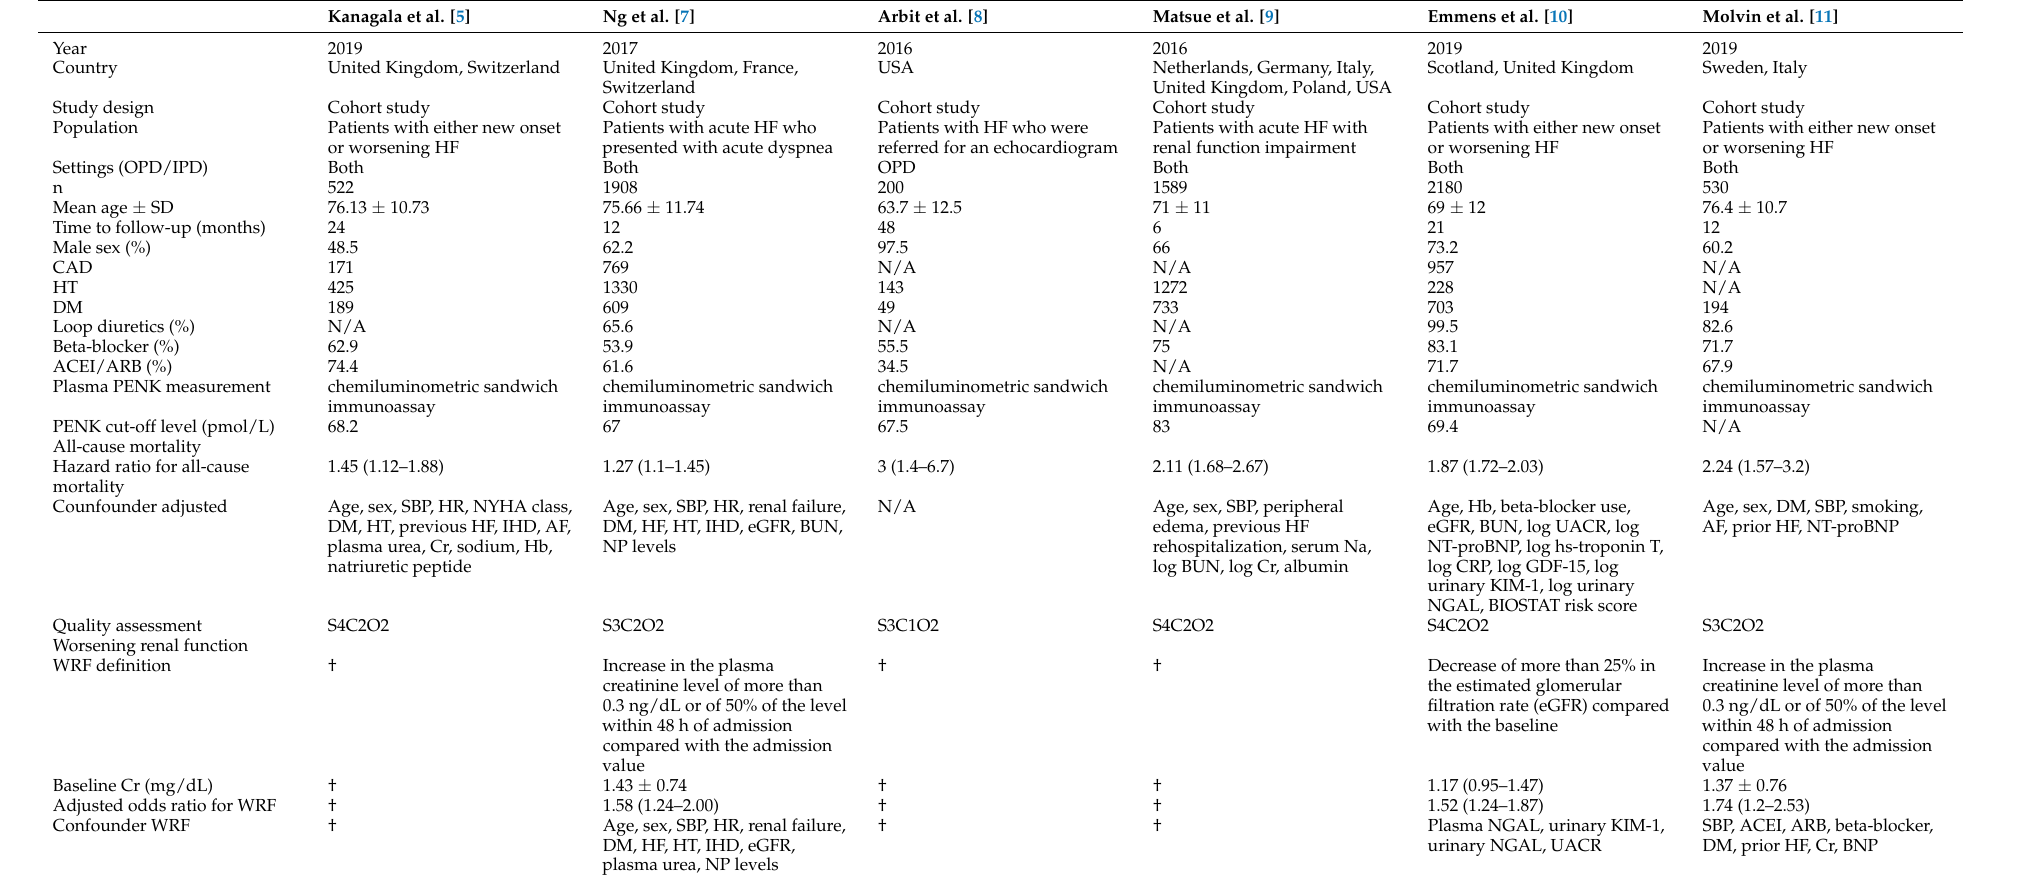
Table 1. Main characteristics of the studies included in the meta-analysis of the associations of plasma PENK levels at the time of admission and their predictive prognosis including all-cause mortality, rehospitalization, and worsening renal